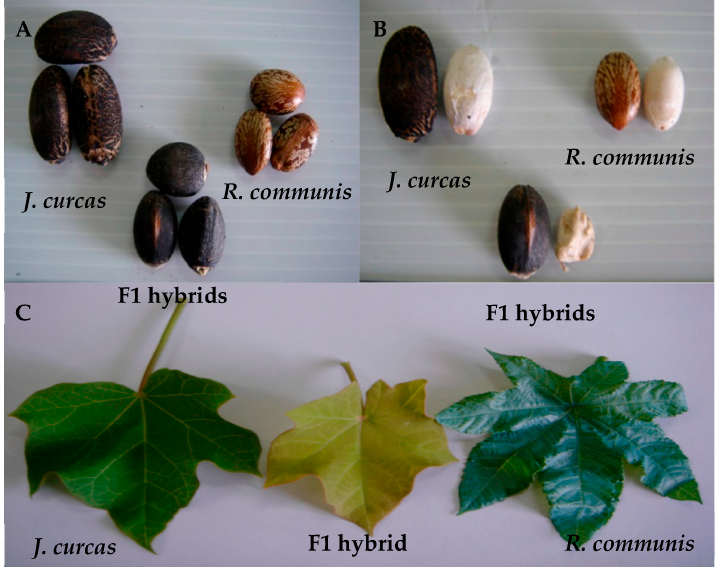
Figure 4. Morphological characteristics of F 1 hybrid from J . curcas ( ♀ ) and R . communis ( ♂ ) including, ( A ) seeds, ( B ) seed kernel, and ( C ) leaf. Table 2. Growth characteristics of the intergeneric hybrids.